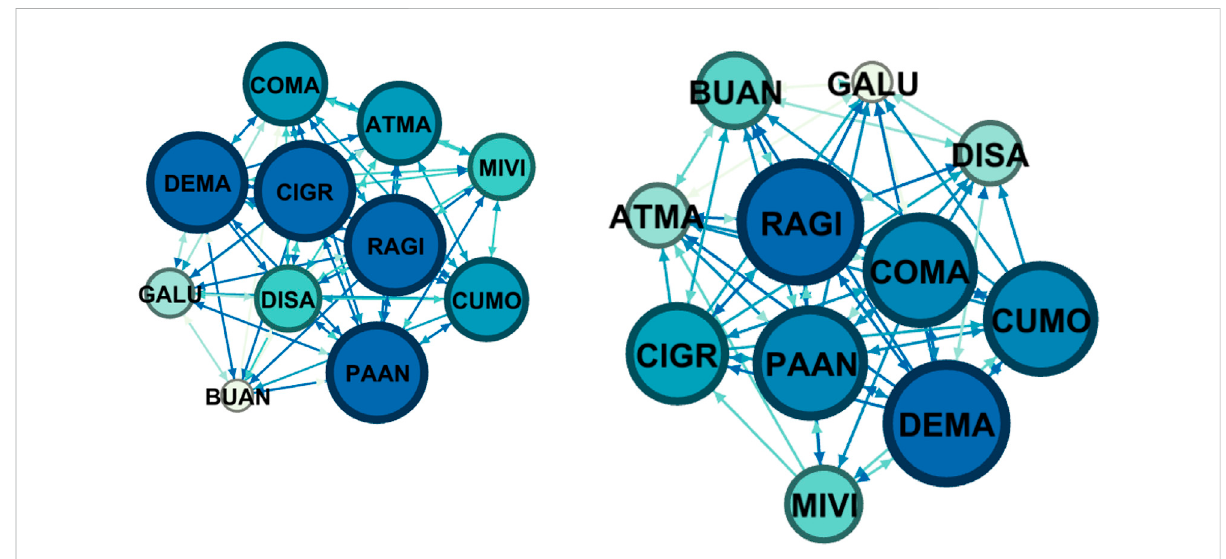
FIGURE 4 Pre-Test (on the left) and post-test (on the right) Sociograms on group organization dimension for the control group.